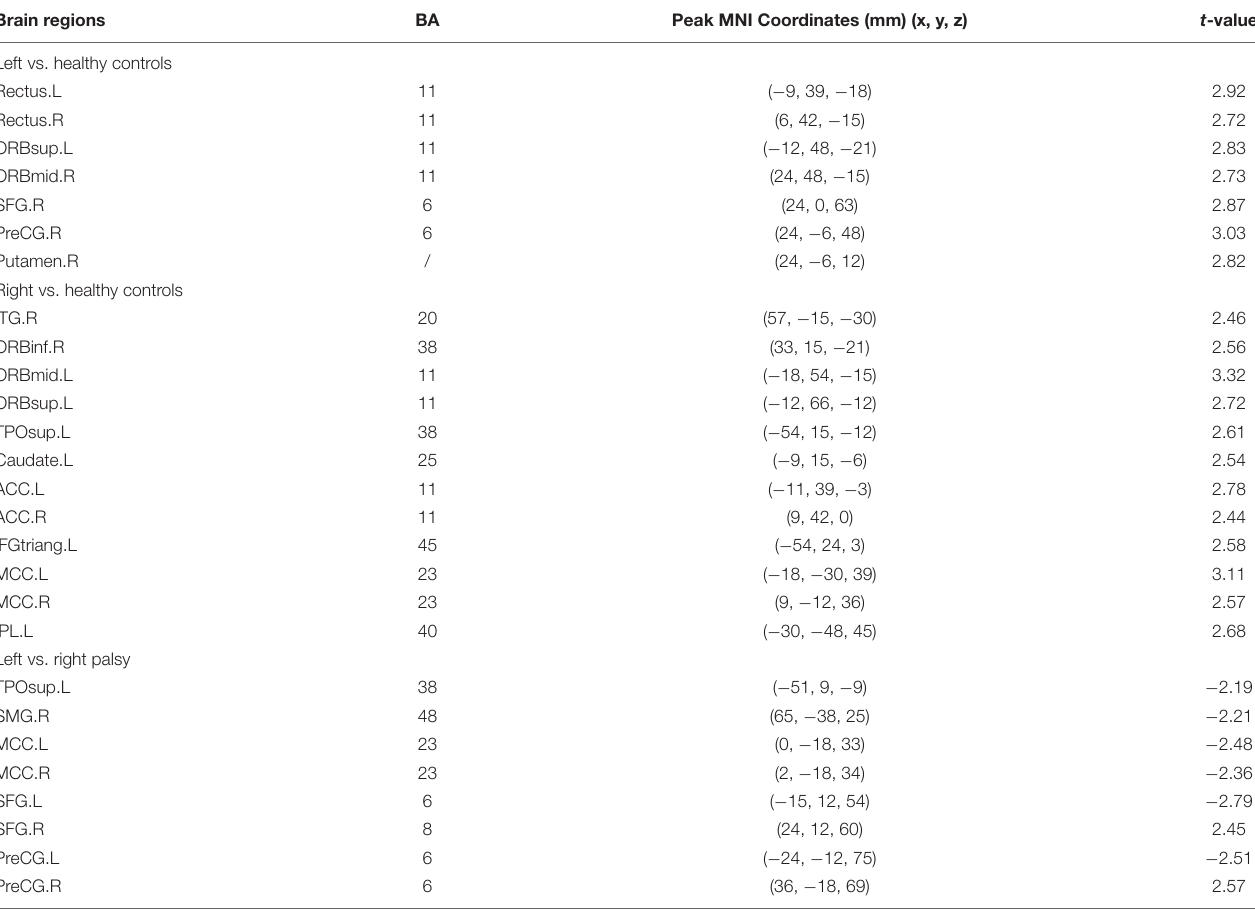
TABLE 2 | Brain regions showing group fALFF differences in Post hoc t-tests analysis. Brain regions BA Peak MNI Coordinates (mm) (x, y, z) t -value Left vs. healthy